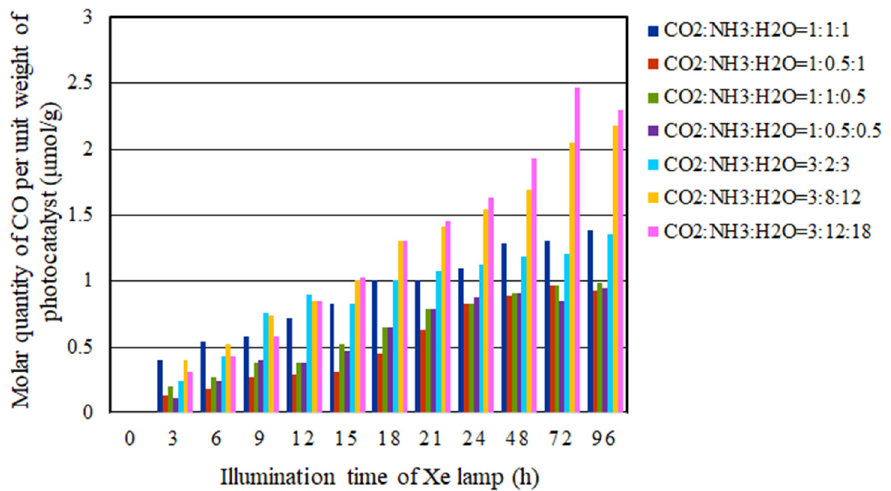
Figure 7. Comparison of molar quantity of CO per unit weight of photocatalyst under the illumination condition of Xe lamp without UV light. The pulse number is 500. The highest CO 2 reduction characteristic is obtained under the condition of the molar ratio of CO 2 /NH 3 /H 2 O = 3:12:18 where the molar quantity of CO per unit weight of photocatalyst is 2.5 mol/g.